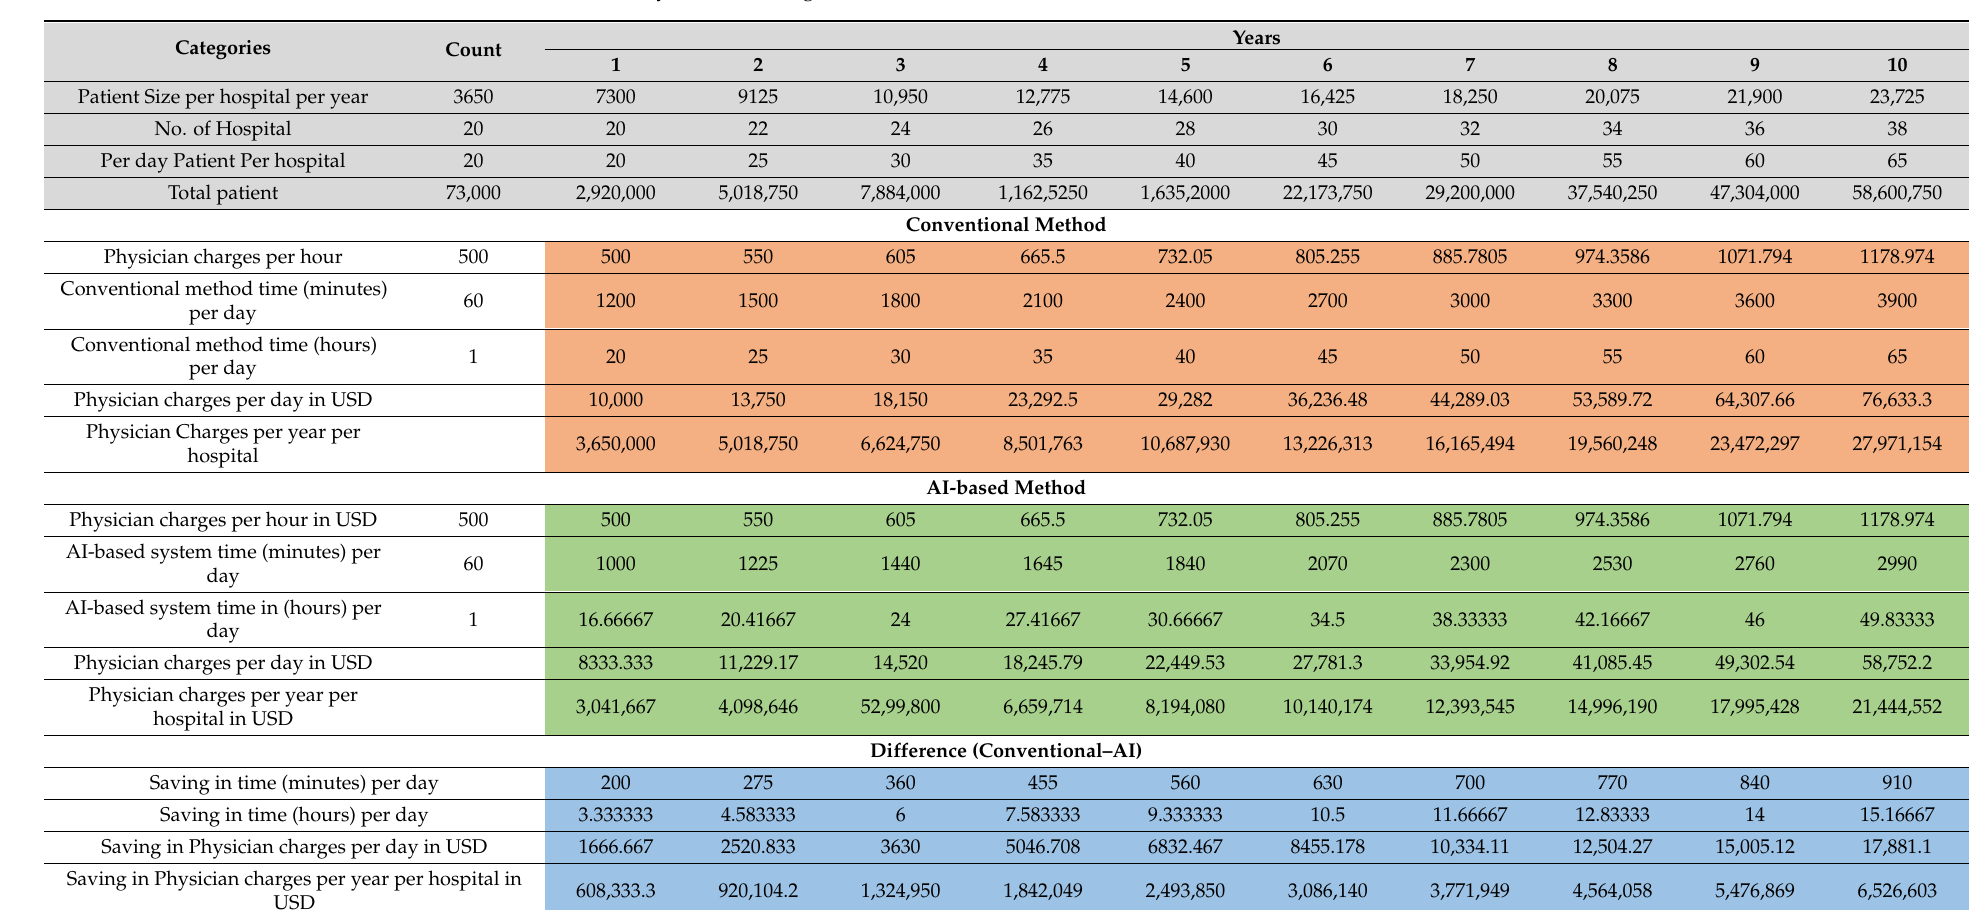
Table A1. Cost Effective analysis for the